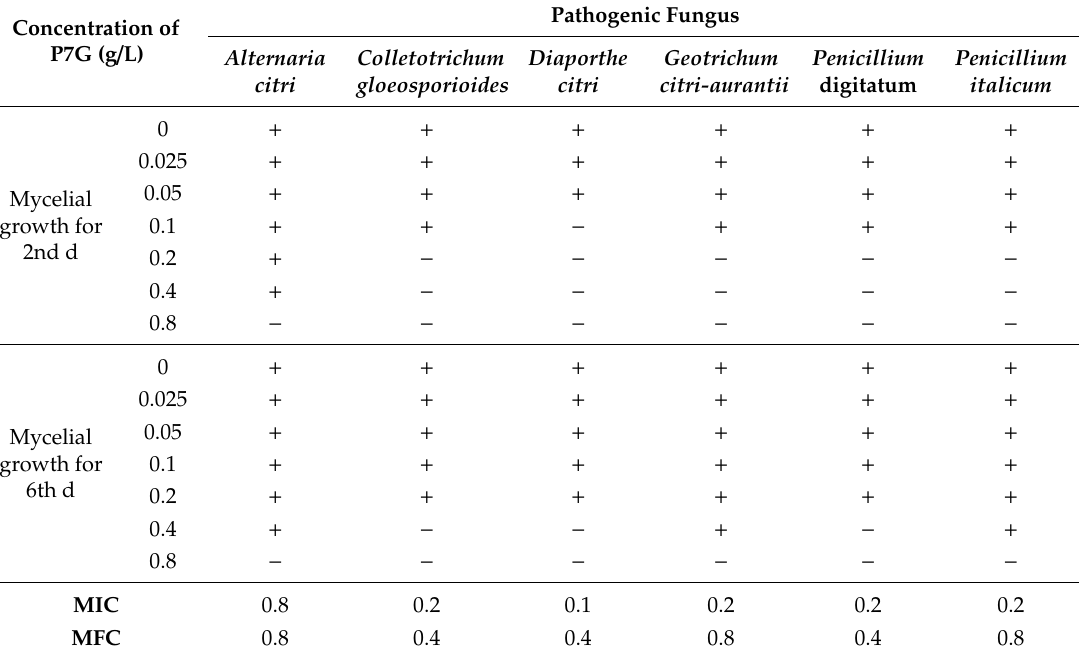
Determination of minimal inhibitory concentration (MIC) and minimum fungicidal concentration (MFC) values of pinocembrin-7-glucoside (P7G) against postharvest pathogenic fungi in citrus